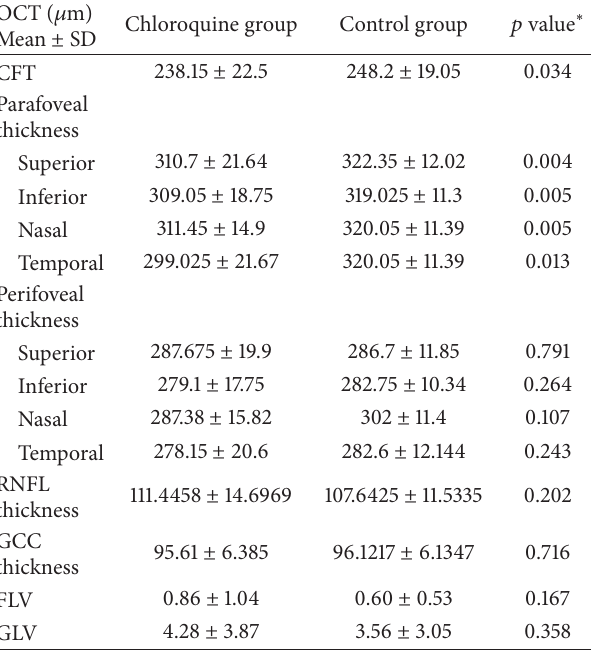
Table2:ComparisonbetweenthedifferentOCTparametersinboth